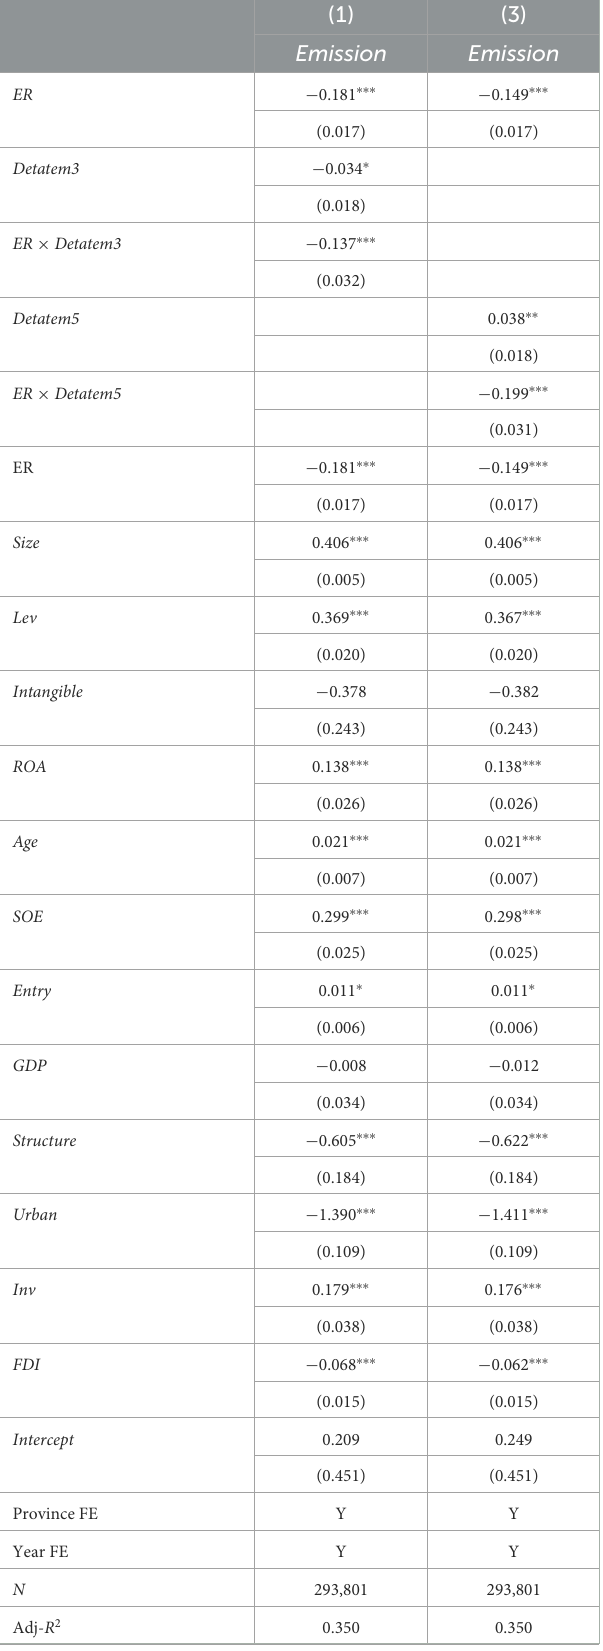
TABLE 10 The effect of the strength of environmental